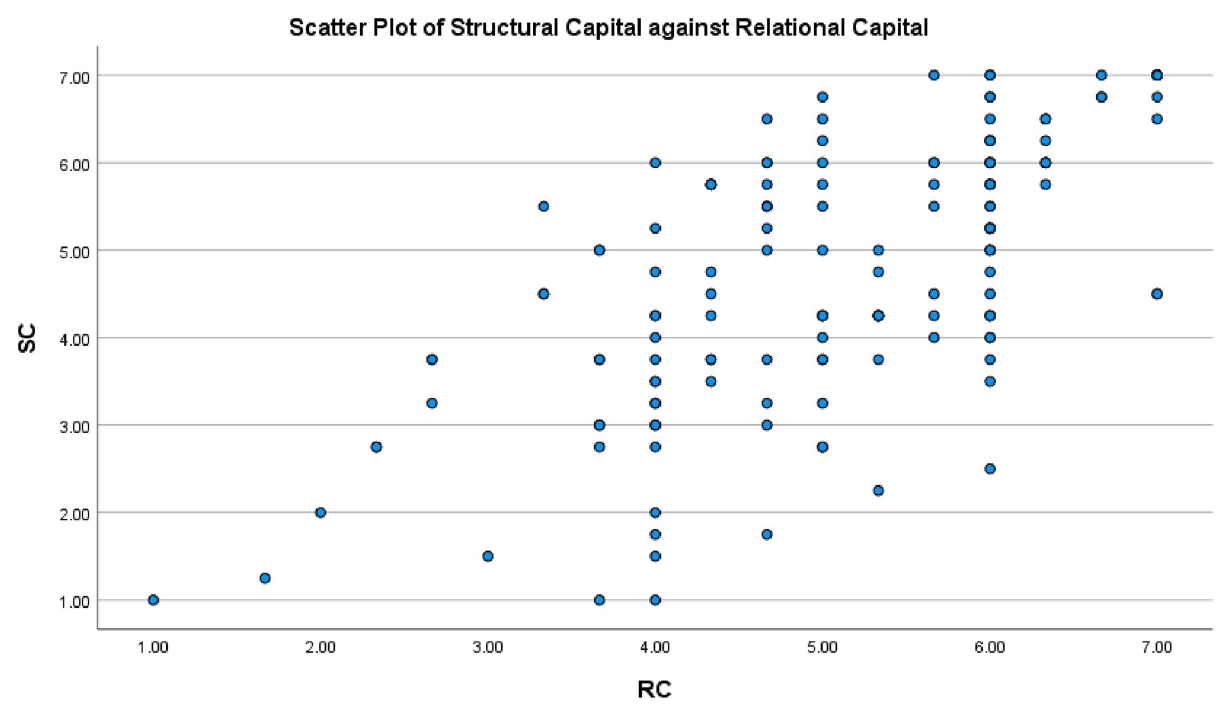
Fig 3. Scatter plot between the structural capital and relational